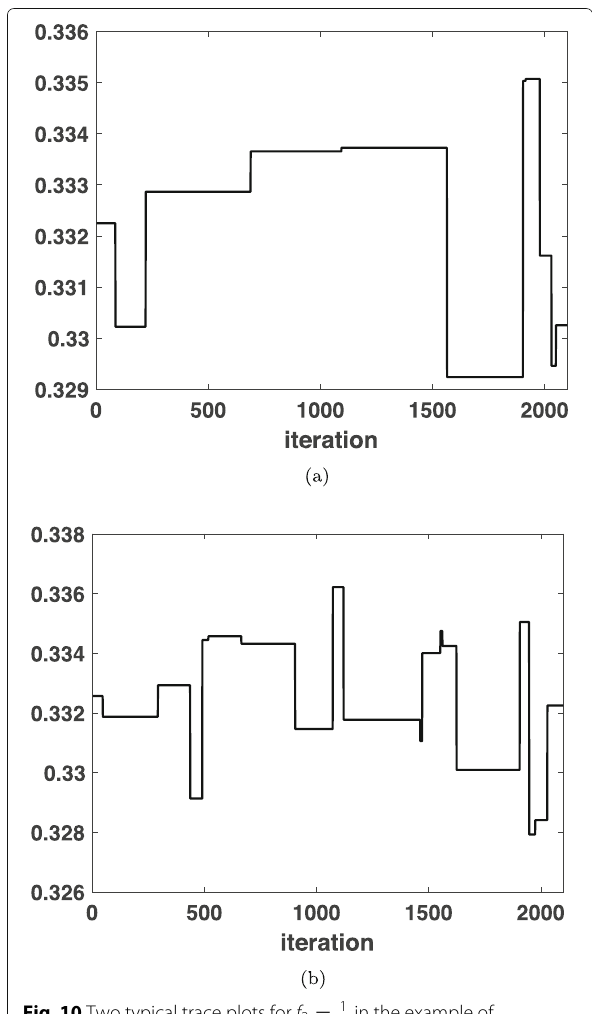
Fig. 10 Two typical trace plots for f 2 = 1 Section 6.5 using the OMCMC-MTM algorithm with T v = 2 vertical steps of an MH algorithm, T h = 1 horizontal steps of the MTM algorithm, and E T = 700 target